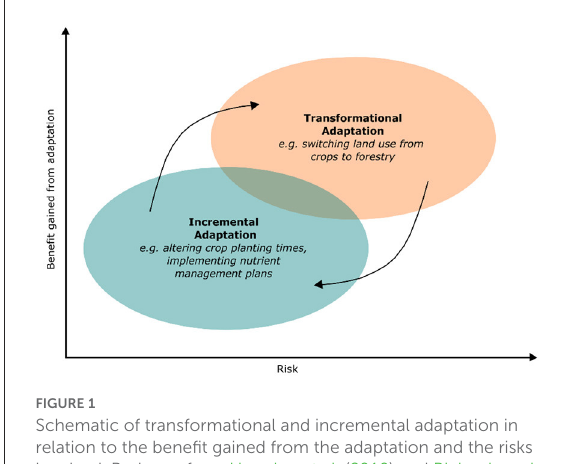
FIGURE1 Schematic of transformational and incremental adaptation in relation to the benefit gained from the adaptation and the risks involved. Redrawn from Howden et al. (2010) and Rickards and Howden (2012), taking the “Adaptation Action Cycle” (Park et al., 2012) into consideration. The black arrows represent information provided by monitoring and evaluation tracking systems, allowing a transition between adaptation states (Park et al.,